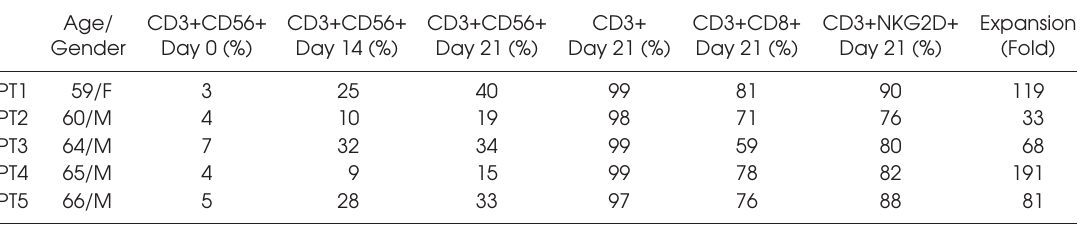
Table 1. Characteristics of patients and CIK